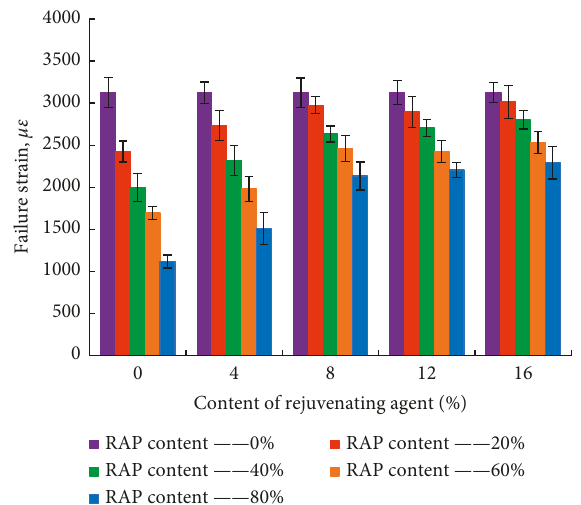
Figure 2: Failure strain test results with different content of regenerant.